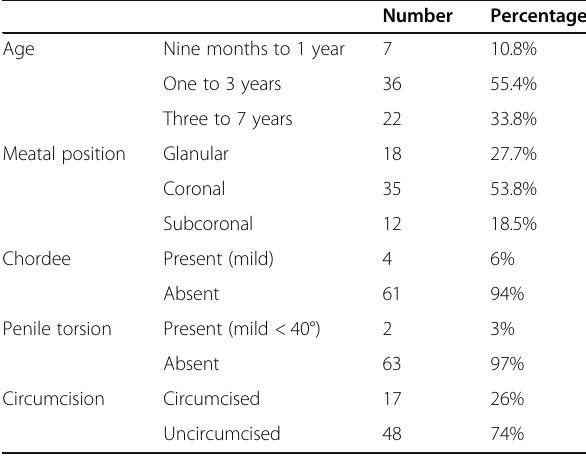
Table 1 Patients